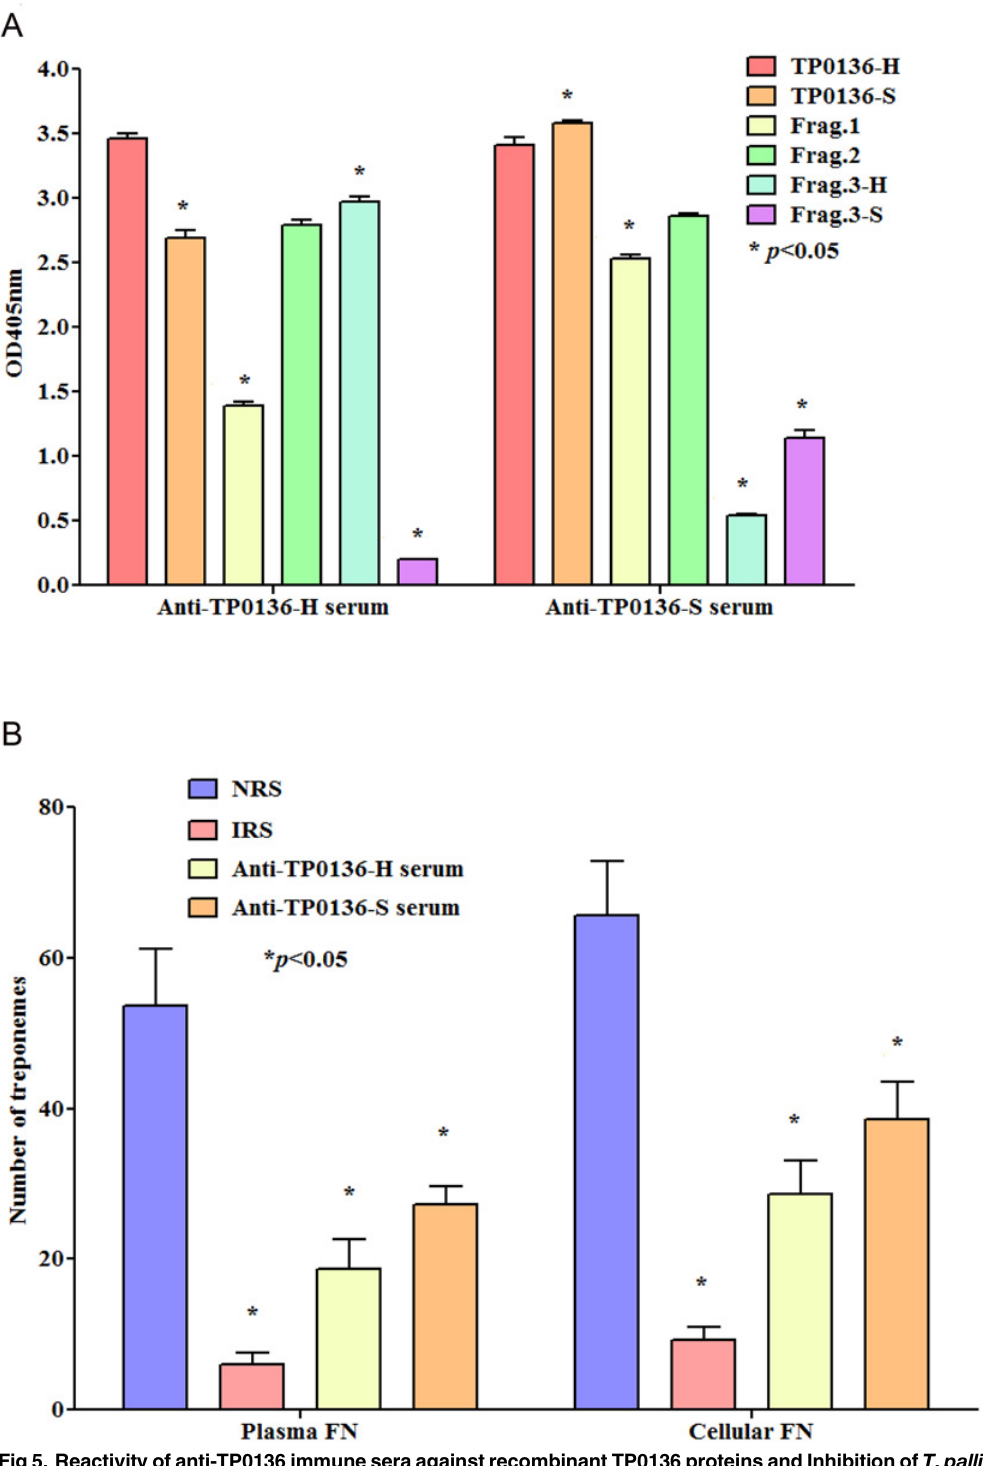
Fig 5. Reactivity of anti-TP0136 immune sera against recombinant TP0136 proteins and Inhibition of T . pallidum attachment to plasma and cellular fibronectin by anti-TP0136 immune sera. (A) Sera obtained from TP0136-H and TP0136-S-immunized rabbits recognized both recombinant full-length proteins and Frag. 1 and Frag. 2. Anti-TP0136-H antiserum recognized Frag.3-H but reacted only weakly against Frag.3-S. Similarly, anti-TP0136-S antiserum recognized Frag.3-S but reacted less well against Frag F3-H. Bars represent the absorbance at 405 nm ± SEM for triplicate samples. Significance between reactivity to single peptides was assessed by Student ’ s unpaired two-tailed t test with significance set at * p < 0.05. (B) Antisera directed against